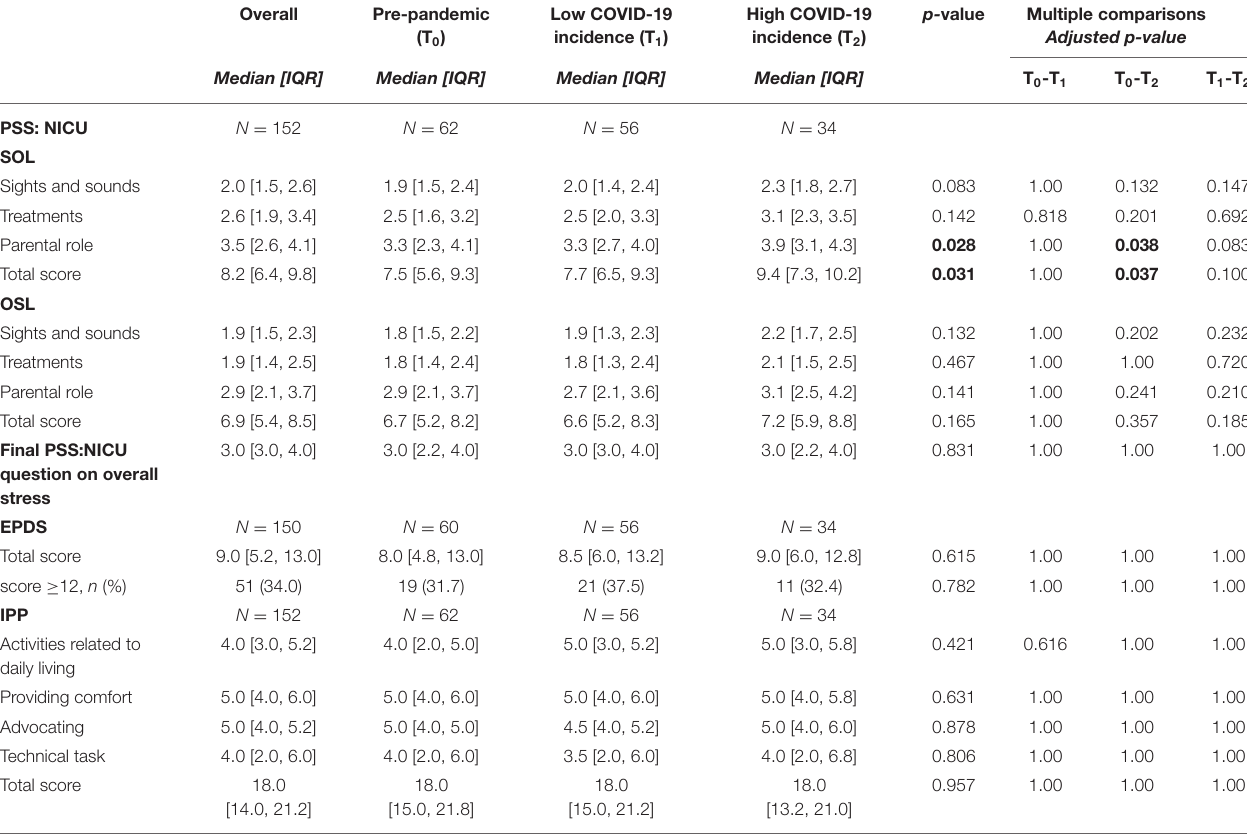
TABLE 2 | PSS-NICU, EPDS, and IPP median scores in three COVID-19 pandemic periods.